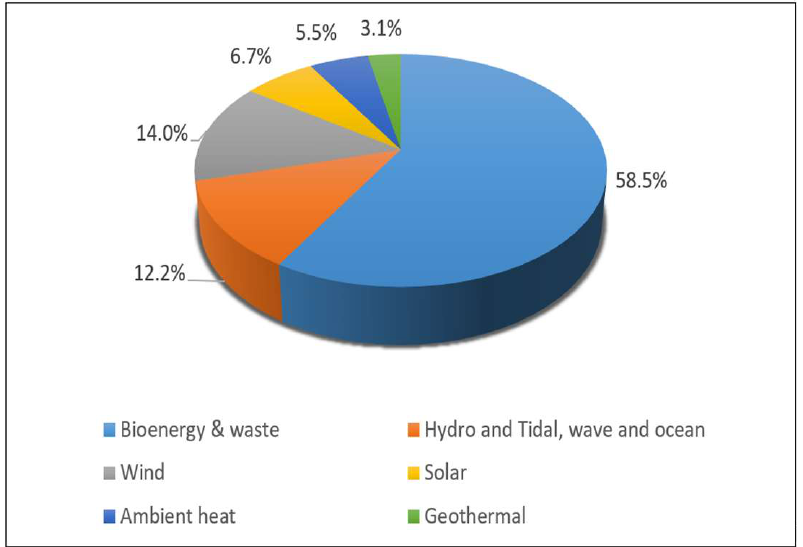
Figure 4. Renewable energy and biofuel production in EU in 2019.